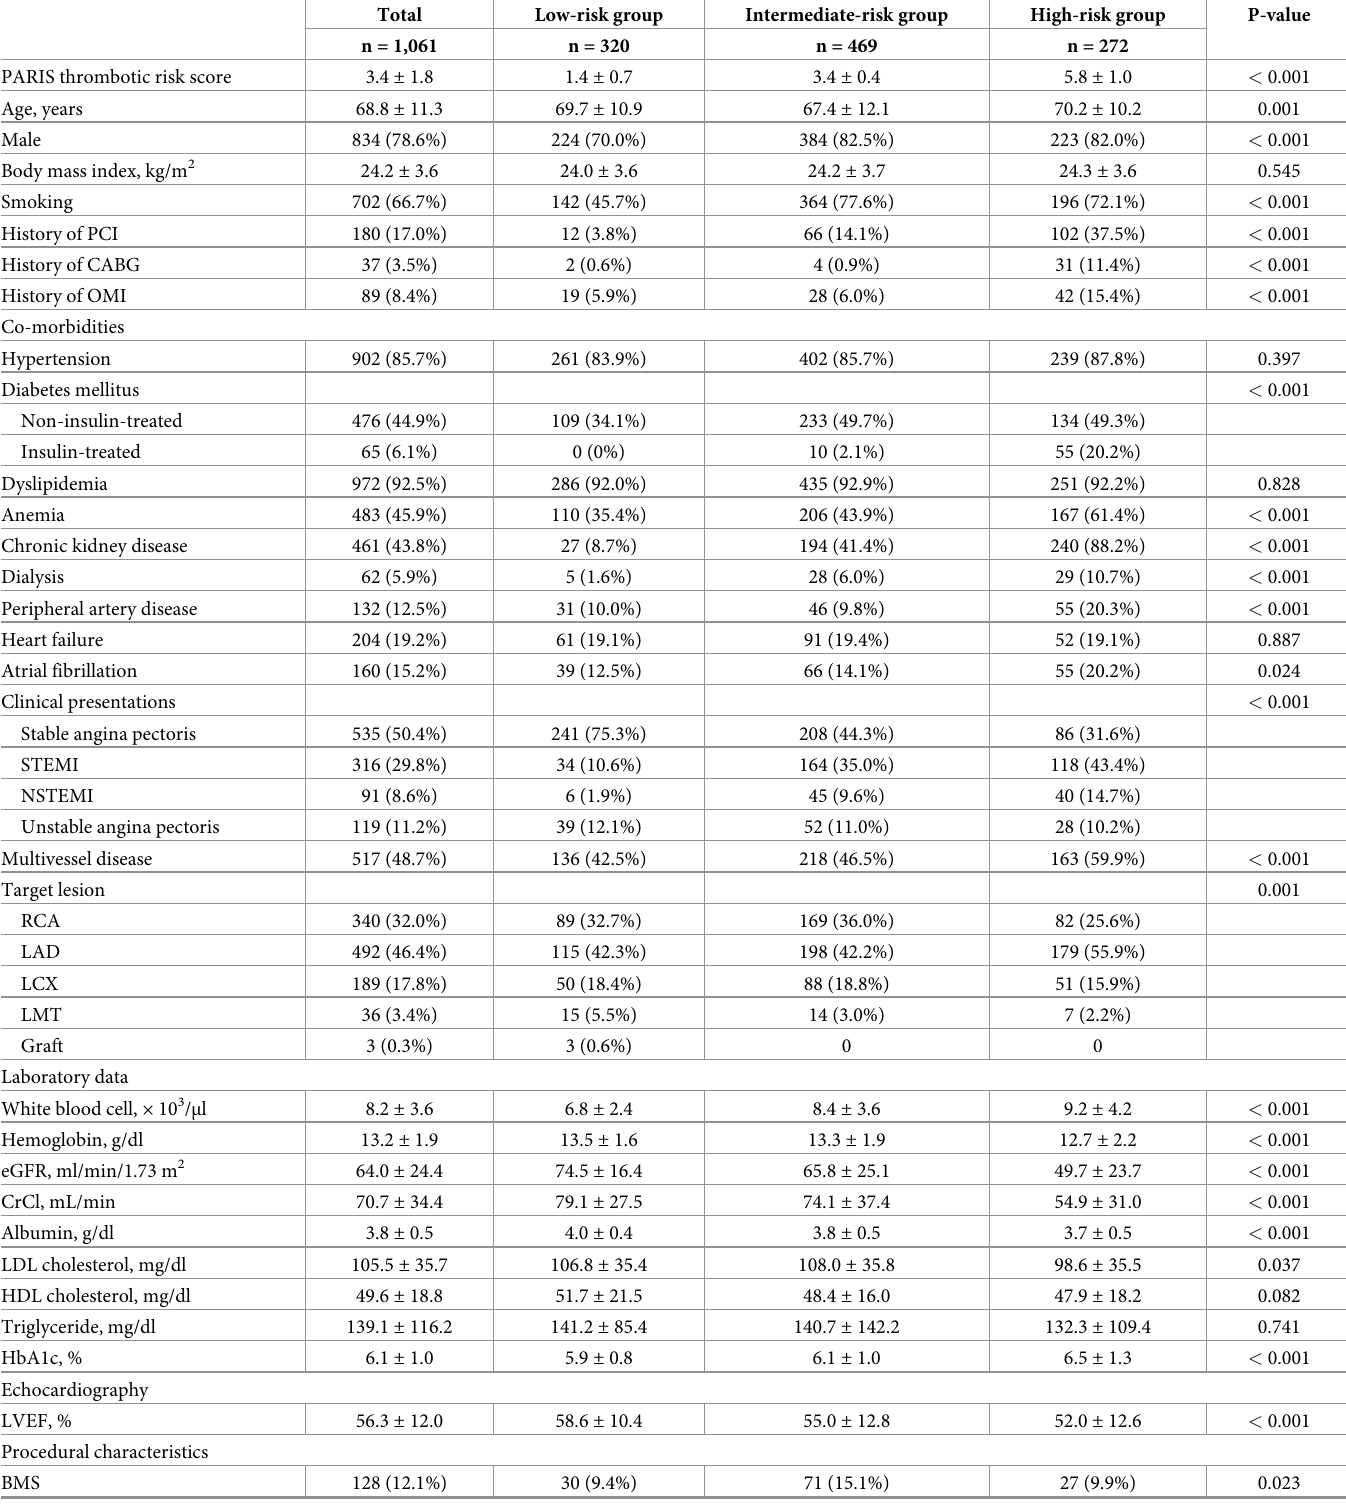
Table 1. Baseline characteristics of patients according to PARIS thrombotic risk